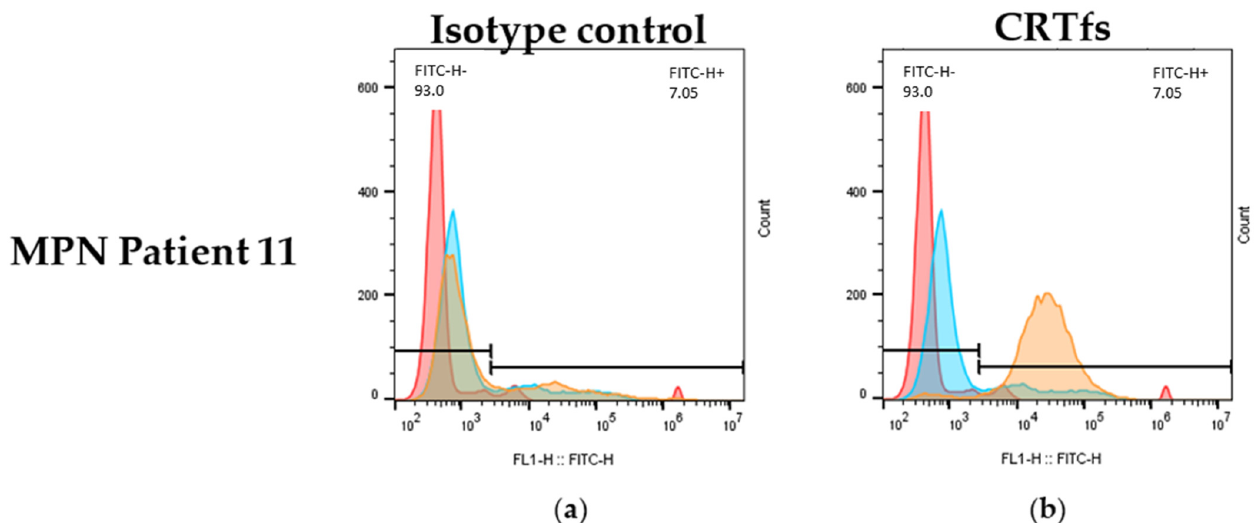
Figure 10. Intracellular leukocyte staining of frameshifted calreticulin (CRTfs) by flow cytometry. ( a ) Negative isotype control staining using a mouse monoclonal antibody of irrelevant specificity ( β -galactosidase). ( b ) Staining using SSI-HYB 385-06 recognizing CRTfs. Colours represent: red, unstained cells; blue, non-specific FITC staining; orange, specific CRT staining.